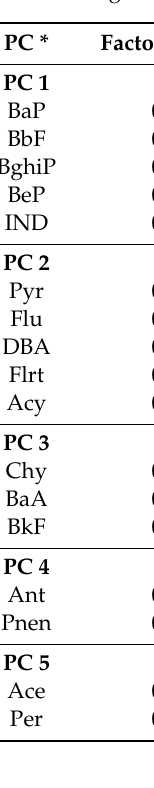
Table 5. Eigenvalues, variance explained, and loadings of